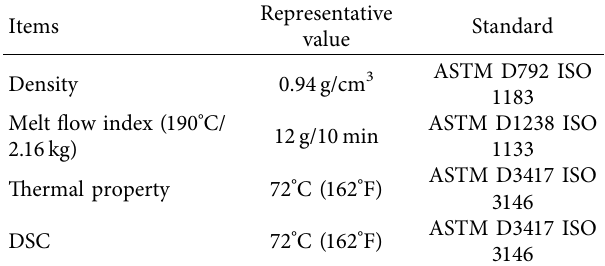
Table 4: Properties of the PTW.